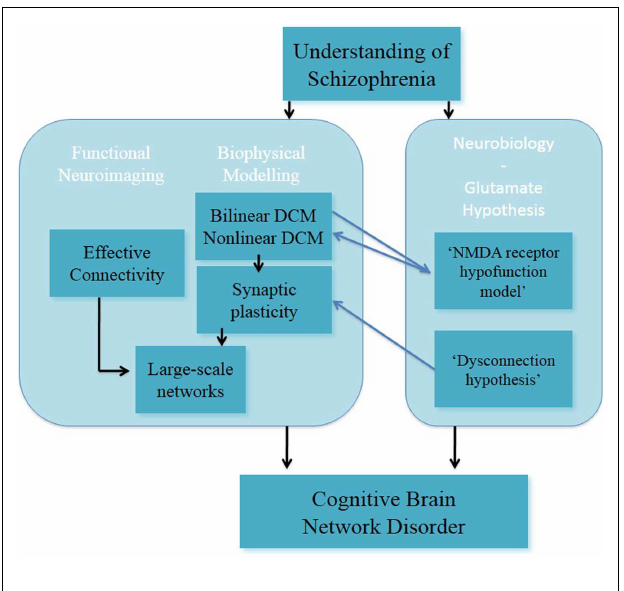
FIGURE 3 | Understanding of schizophrenia as a cognitive brain network disorder – verbal/numeric “N-back” task